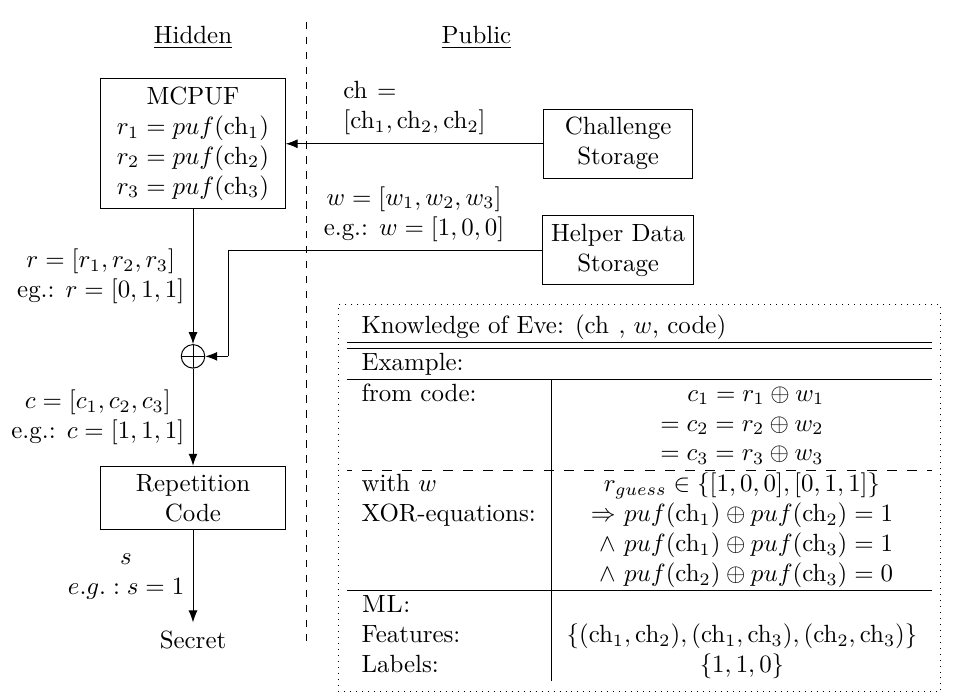
Figure 2: Visualization of the attacker knowledge using a (3,1,3)-repetition code. The left side is hidden from E ; Public information and its exploitation is given on the